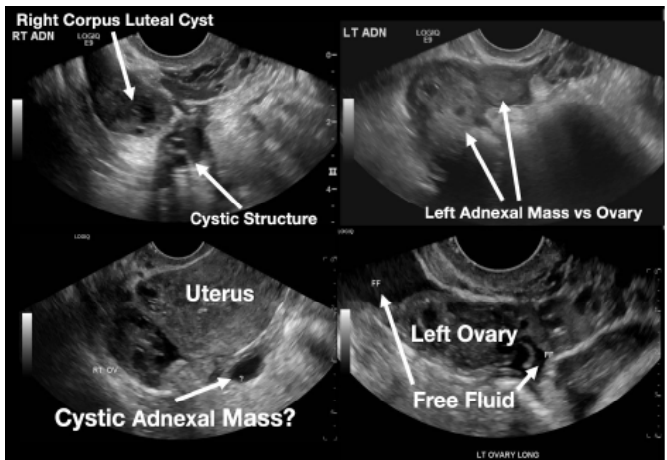
Image 3. This image shows both of the patient’s ultrasound findings as described above for ease of comparison. The upper panel is from the initial encounter and the lower panel is from the patient’s encounter 11 days